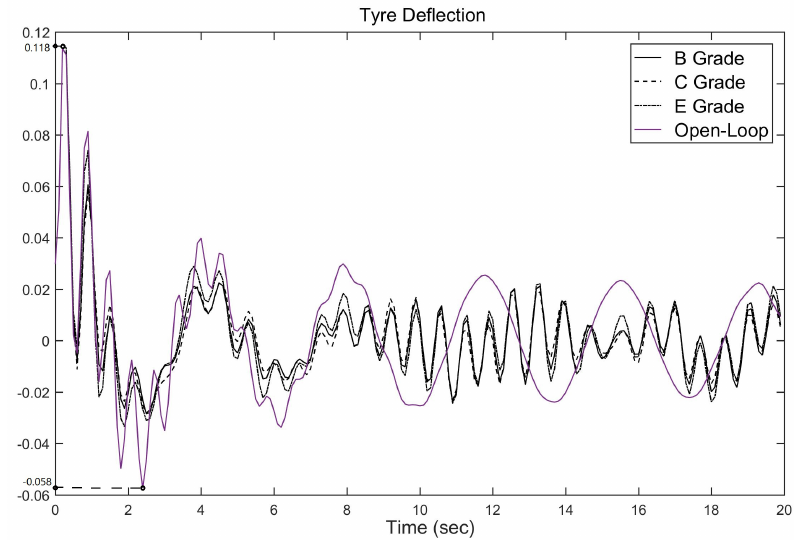
Figure 5. The comparison curves of TD under different road roughnesses.